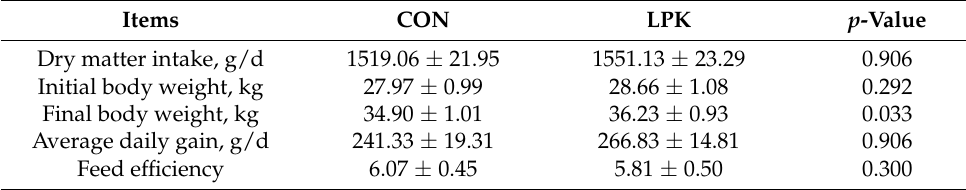
Table 2. Effects of live Pichia kudriavzevii on growth performance of Hu sheep 1 .